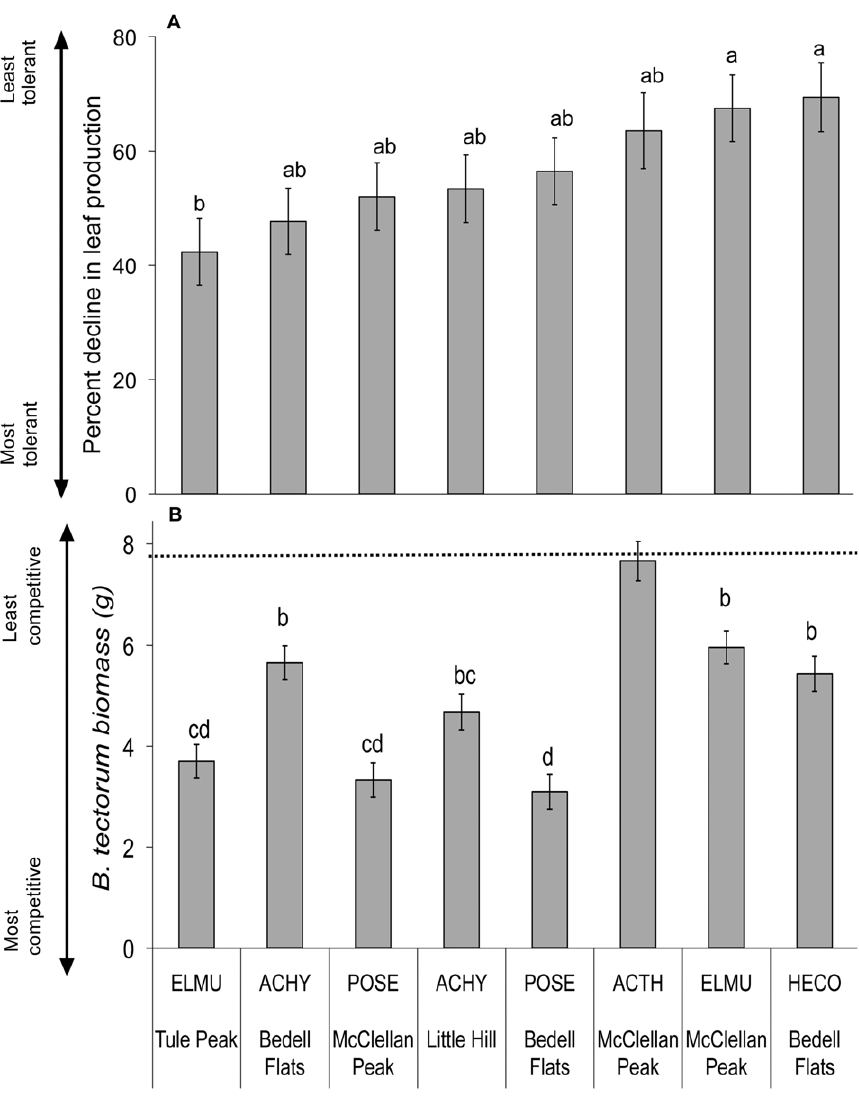
Figure 2. Tolerance and competitive effect of five native perennial grasses. Mean percent decline in biomass of target plants from Bedell Flats, Little Hill, McClellan Peak, and Tule Peak when grown in competition with B. tectorum (a) and biomass of B. tectorum when grown with target species (b). Dotted line indicates B. tectorum biomass when grown in monoculture (not included in analysis but plotted for comparison). Different letters within figures indicate significant differences ( P , 0.05) using Tukey adjusted least square means for multiple comparisons. POSE = Poa secunda , ACHY = Achnatherum hymenoides , HECO = Hesperostipa comata , ELMU = Elymus multisetus , and ACTH = Achnatherum thurberianum.